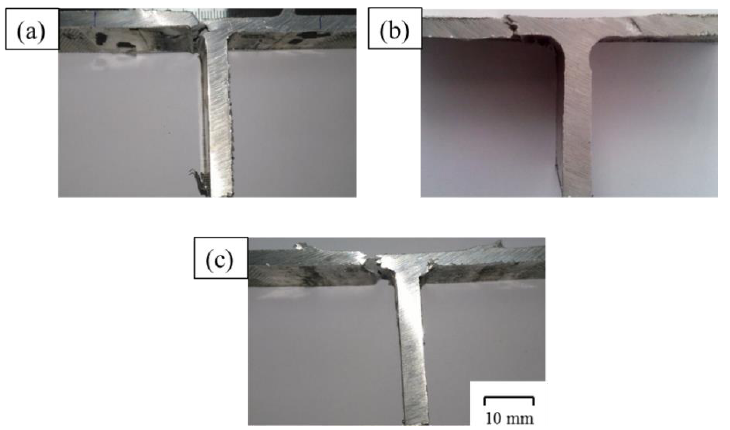
Figure 16. Photographs of fracture locations of T-butt welded specimens along skin. ( a ) 400 rpm, ( b ) 600 rpm, and ( c ) 800 rpm.